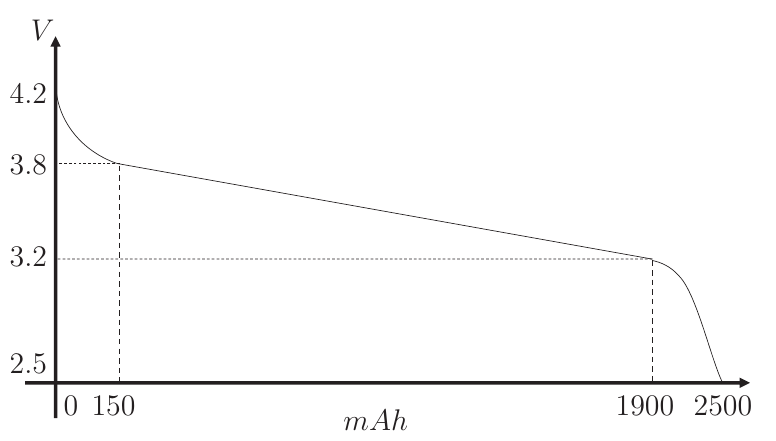
Figure 8. Characteristic curve of the 18,650